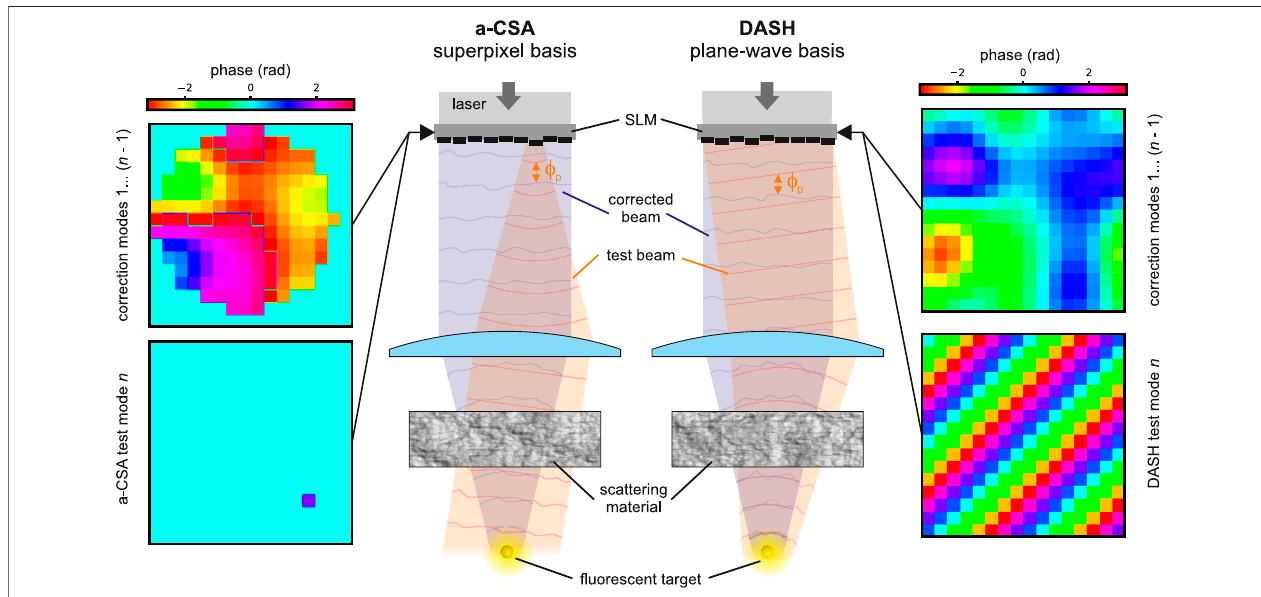
FIGURE 1 | Sensorless AO methods for nonlinear microscopy. a-CSA uses a superpixel basis, DASH a plane-wave basis of test modes on a fl uorescent target. Respective examples of a test mode (bottom) and the compensation pattern at the corresponding step are shown on the left and right. For a-CSA the order of tested modes isby increasing distance tothe pupil center, for DASHthe order isby increasing spatial frequency. During phase-stepping, the relative phase ϕ p ofthe test mode with respect to the compensation pattern is varied (see main text).